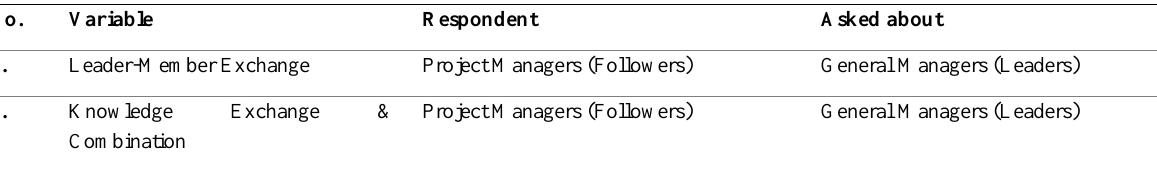
Table 2: Data Collection